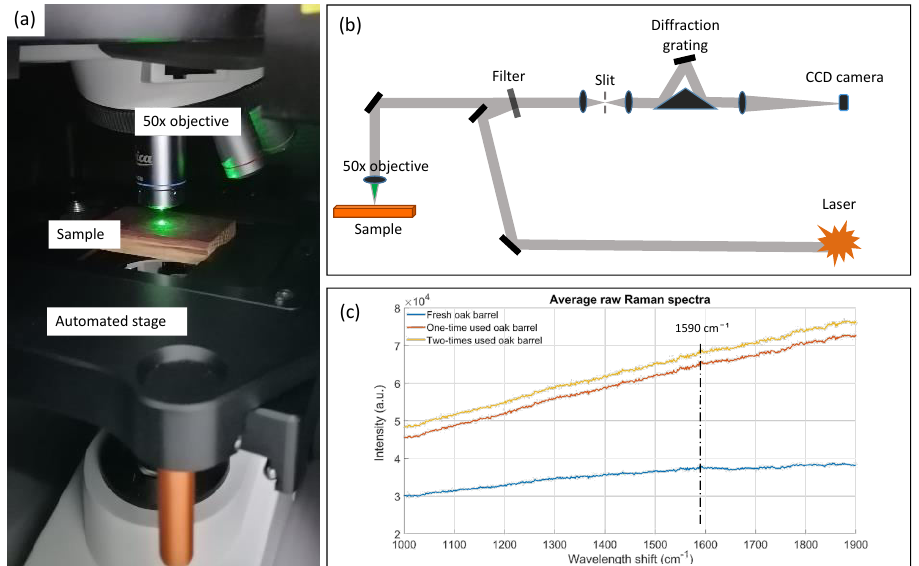
Figure 3. Raman spectroscopy measurement setup. ( a ) Oakwood is placed in the InVia Renishaw confocal Raman spectrometer and illuminated with 532 nm laser spot. ( b ) Schematic overview. ( c ) Raw Raman spectra of three oak